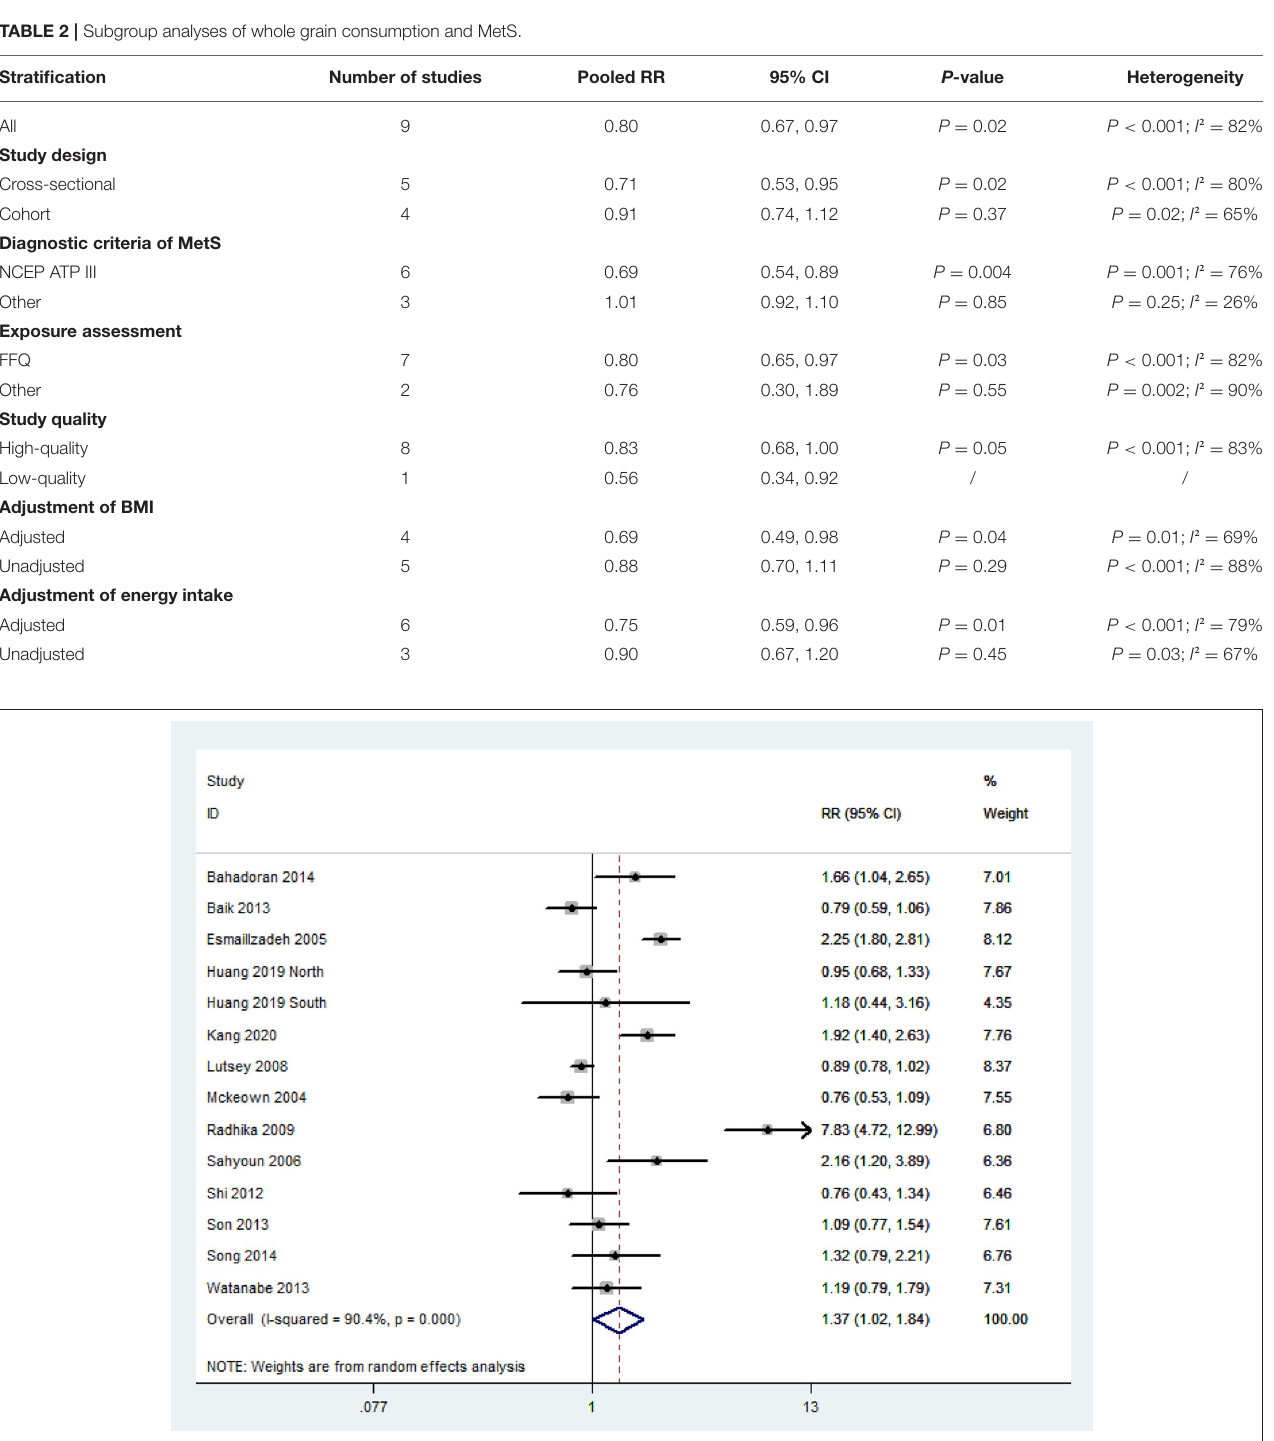
FIGURE 3 | Forest plot of meta-analysis: Overall multi-variable adjusted RR of MetS for the highest vs. the lowest category of refined grain consumption.